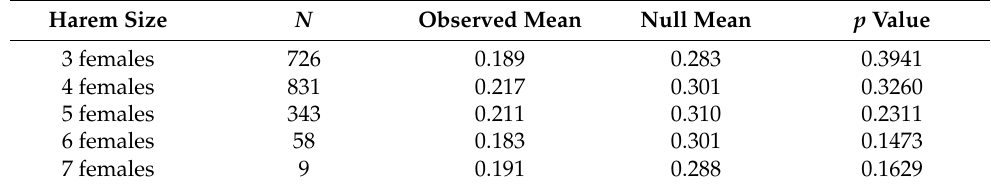
Table 3. Summary table of the observed and null mean proximity index of females within a harem, for each harem size of 3 to 7 females per male across all treatments. Proximity index closer to 1 indicates females are highly clumped. While an index of 0 indicates the females are evenly spread around the male.